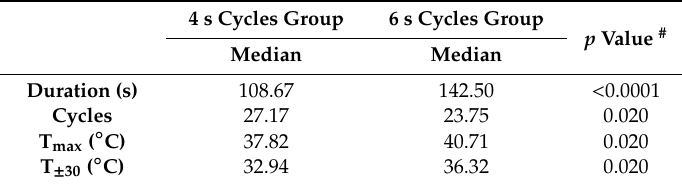
Table 2. Medians of the study